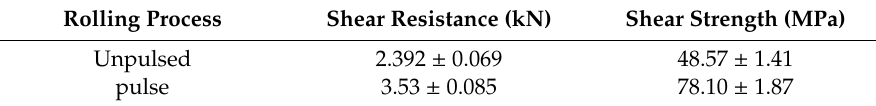
Table 4. Shearing strength in bonding zone of Cu / Al laminated